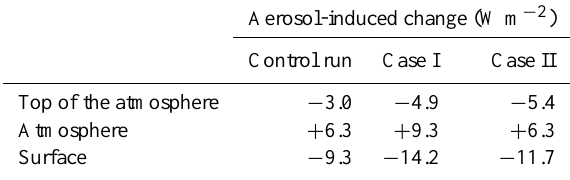
Table 3. Aerosol-induced changes in shortwave radiation flux cal- culated by the WRF-Chem model in the control run and two sen- sitivity studies (Case I and Case II) for March 2012, averaged for 60–95 ◦ E and 0–36 ◦